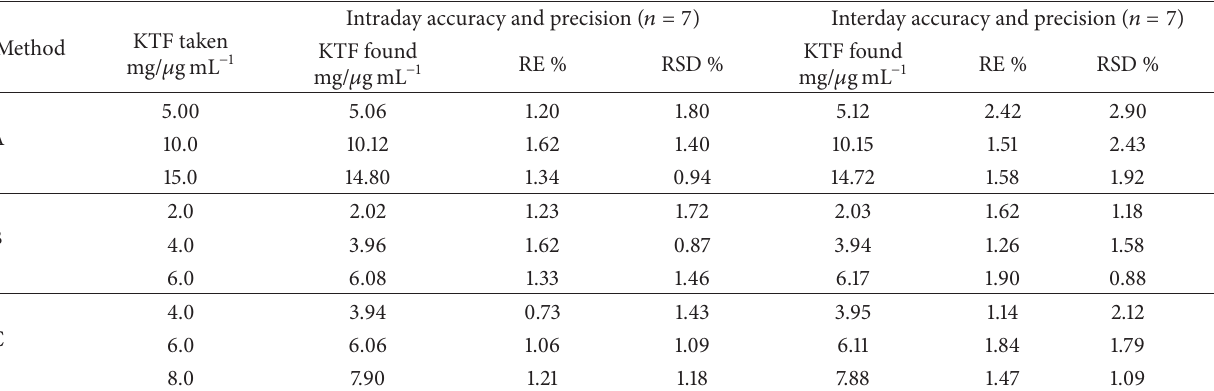
Table 3: Results of intraday and interday accuracy and precision